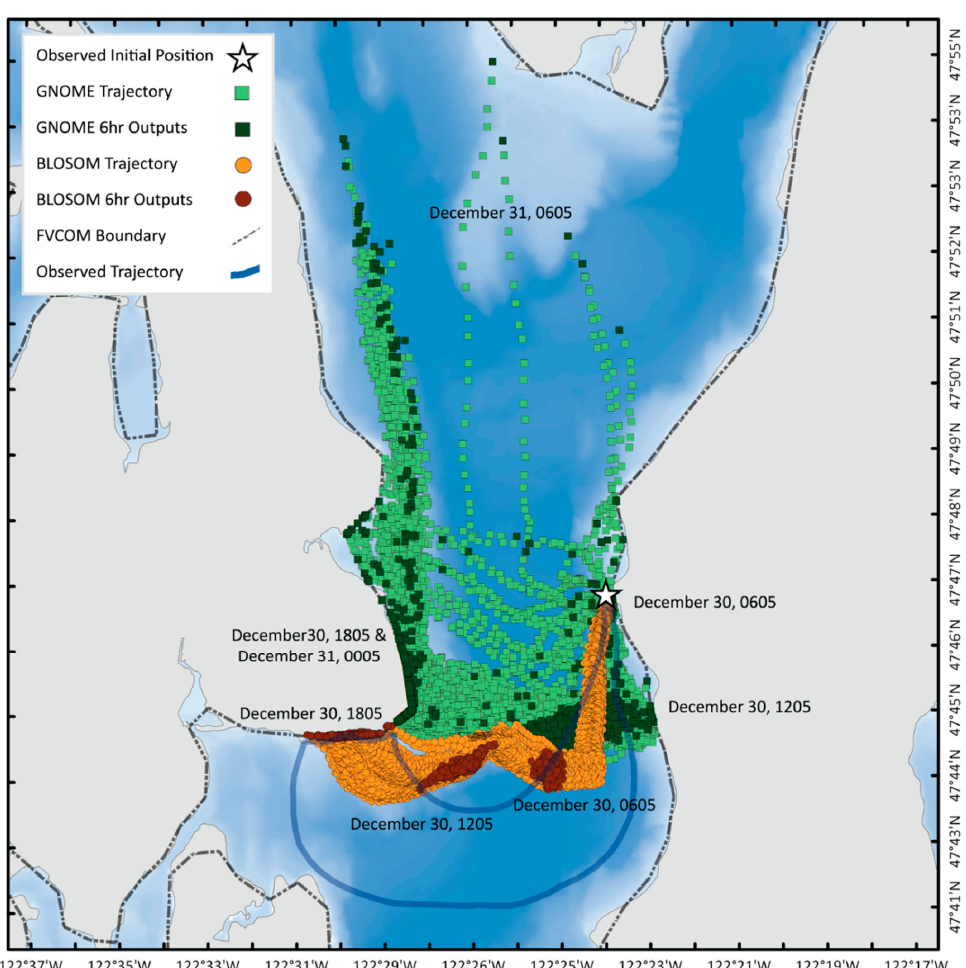
Figure 18. Simulation including diffusion with a thousand particles; test 7. Table 10. Parameters for testing number of